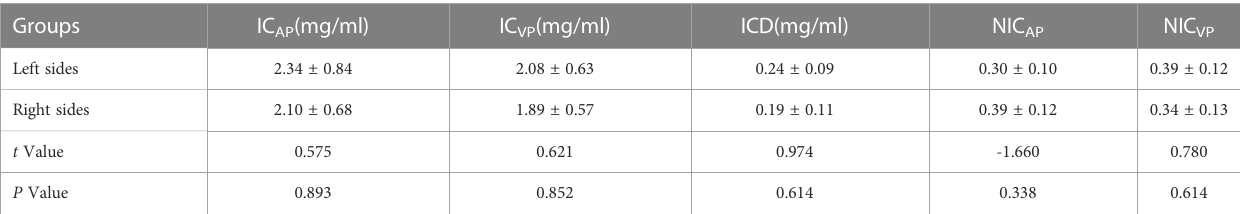
TABLE 4 Comparison of energy parameters on adrenal iodine maps between the right and left sides in 8 patients without the dominant side.